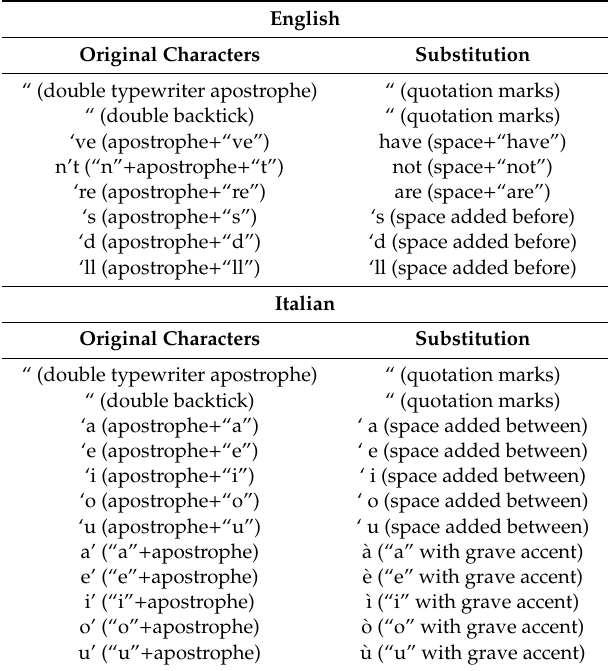
Table 2. Substitution of strings comprising apostrophes.